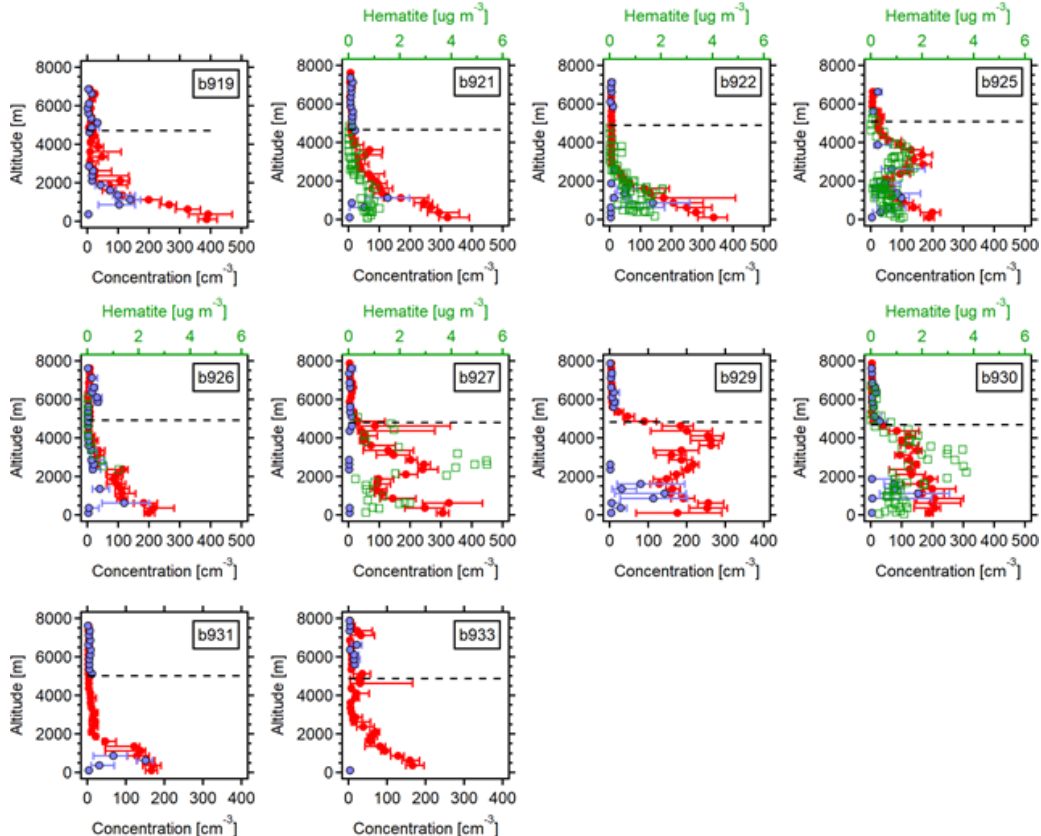
Figure 9. Median concentration (cm − 3 ) as a function of altitude from the CDP (droplet concentrations, red circular symbols), aerosol concentrations from PCASP (blue circular symbols) and mean hematite concentrations (green square symbols) from SP2. Error bars represent lower and upper quartile ranges. Flight numbers b919–b933 are labelled on each